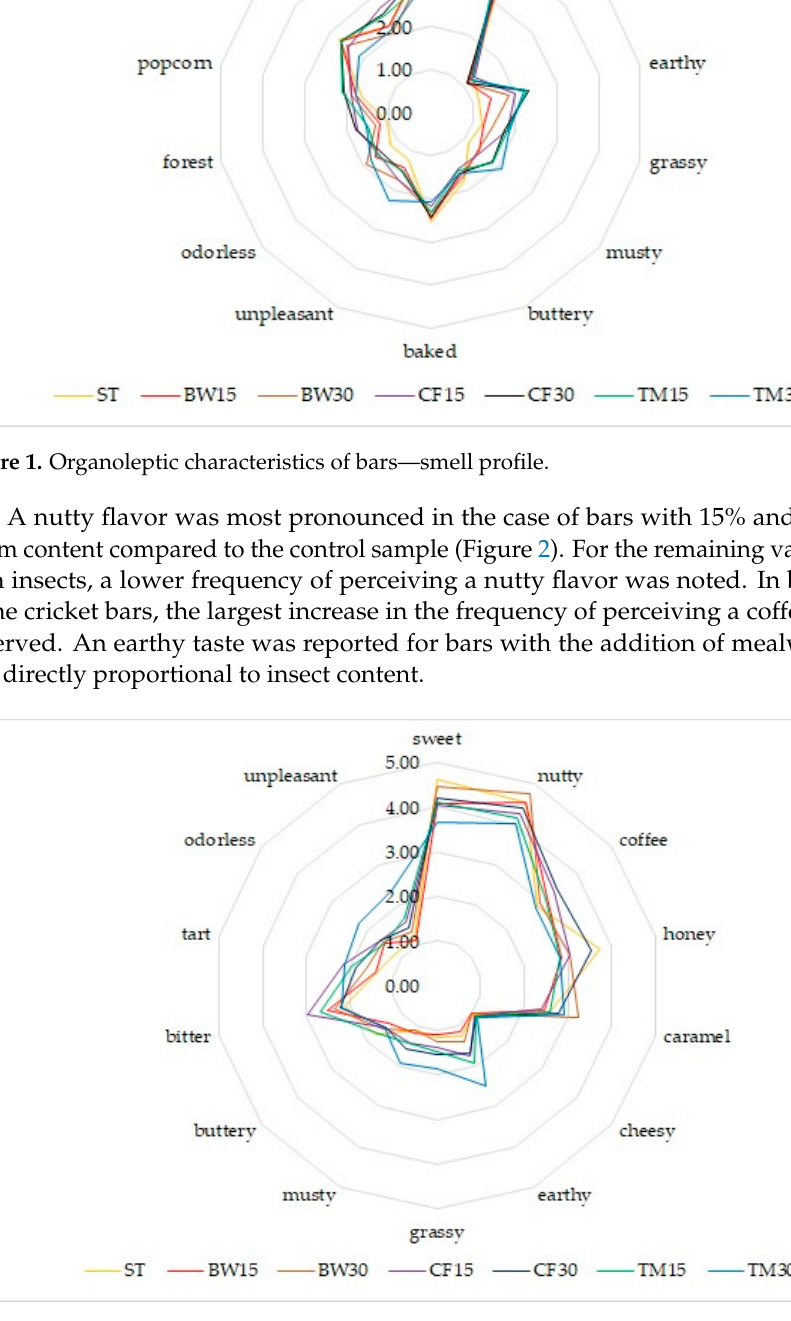
Figure 2. Organoleptic characteristics of bars—taste profile.